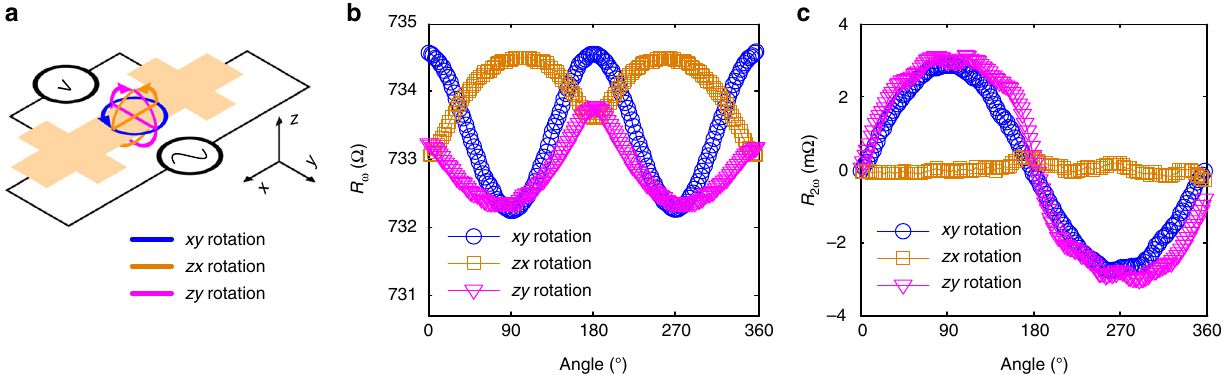
Fig. 2 Longitudinal resistance. a Longitudinal resistance measurement setup and de fi nitions of rotation planes. b First harmonic and c second harmonic resistances of 10 QL BST sample at 150 K are shown when the external fi eld is rotated in three orthogonal planes. The starting points and zero angles are at x +, y +, and z +, the directions of rotation for increasing angle are x to y , z to x, and z to y , for xy , zx, and zy rotations, respectively